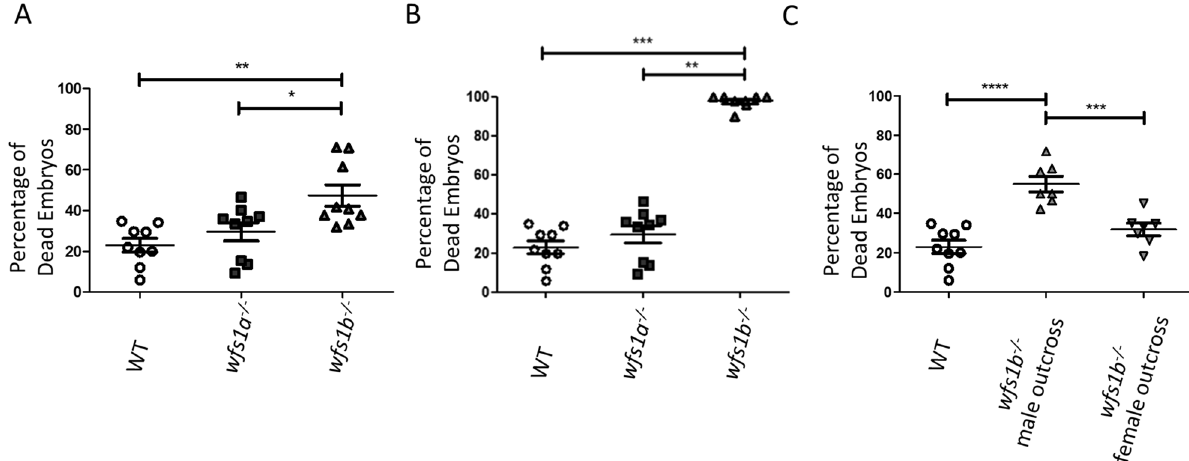
Figure 5. Fertility of wfs1a −/− and wfs1b −/− zebrafish. ( A ) Percentage of dead embryos at 24 hpf produced from adults < 9 months (n = 9). ( B ) Percentage of dead embryos at 24 hpf produced from adults > 9 months (n = 9). ( C ) Percentage of dead embryos at 24 hpf in randomly selected embryos from wfs1b −/− zebrafish (male or female) that were outcrossed to WT (controls n = 9, wfs1b −/− outcrosses n = 7). A total of 50 randomly selected